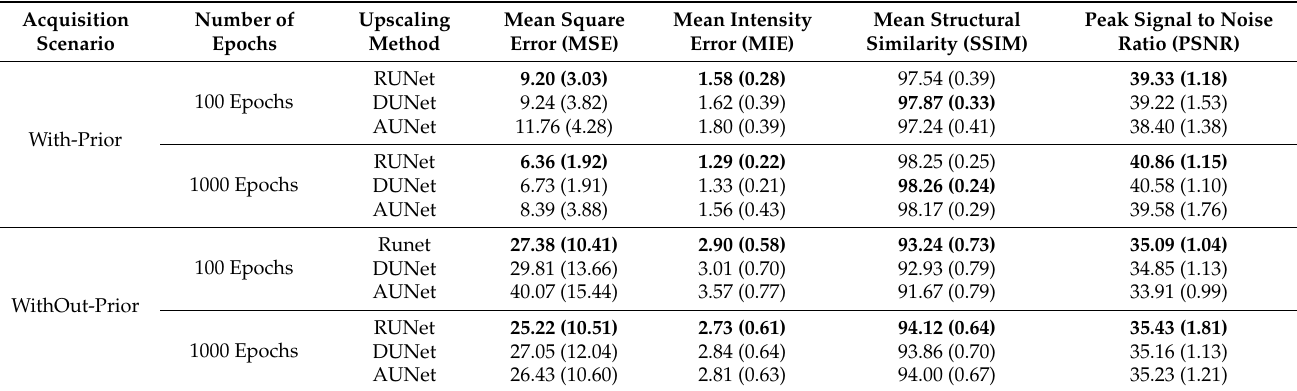
Table 2. Upscaling a 1/4 downsampled (44 × 52) synLQ with the three Unets. The best results are represented in bold. The numbers represent the mean value followed by the standard deviation in parenthesis.